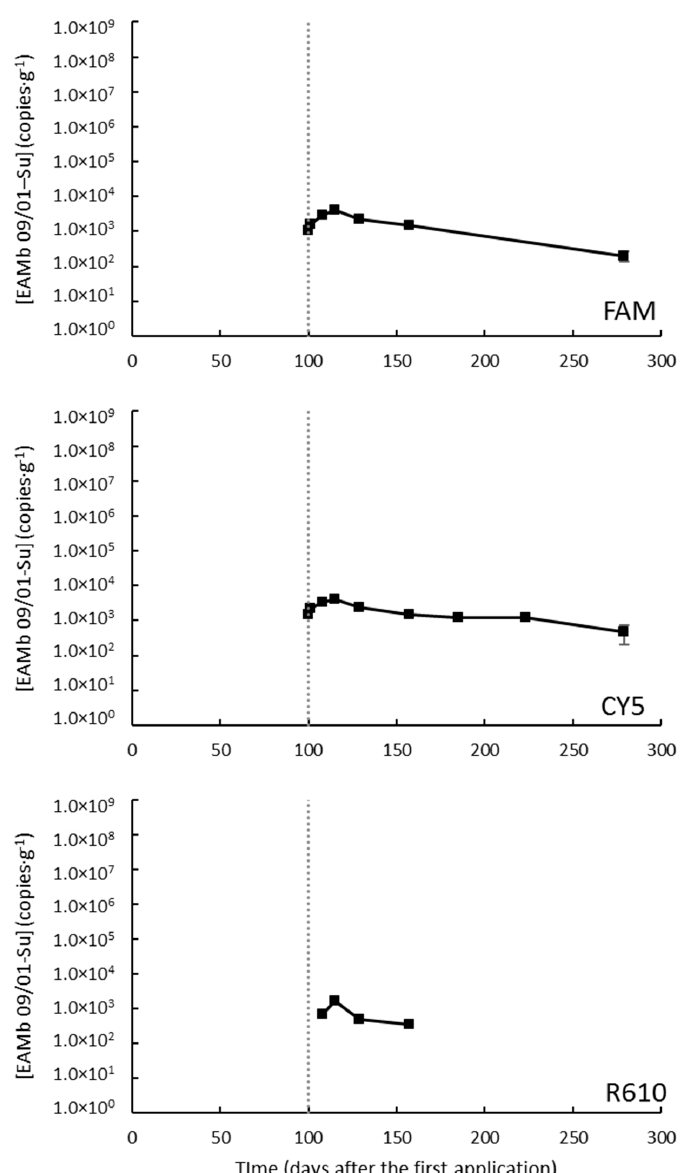
Figure 3. Concentrations of Metarhizium brunneum strain EAMb 09/01-Su in the substrate when applied as oil dispersion in a field trial at Caldes de Montbui under a super-intensive regime. The different panes correspond to the three different markers, labeled as denoted within each pane. Missing data are measurements below the limit of detection. The vertical dotted line indicates the time of the second application. FAM stands for 6-carboxyfluorescein; CY5, for cyanine-5; and R610 for LightCycler ® Red